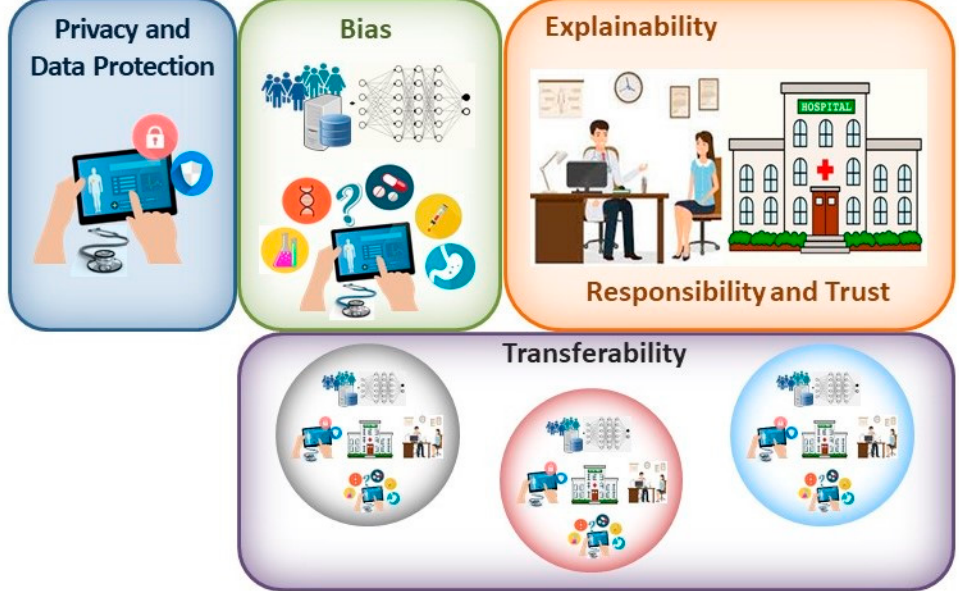
Figure 1. When contemplating the main bioethical issues associated with the clinical implementa- tion of AI solutions, the principal concerns may be related to the privacy and protection of patient data; bias introduced in the design and utilization of these systems; the explainability of the tools employed; responsibility for the output and patient trust in their clinician; and finally, the transfer- ability of these systems.